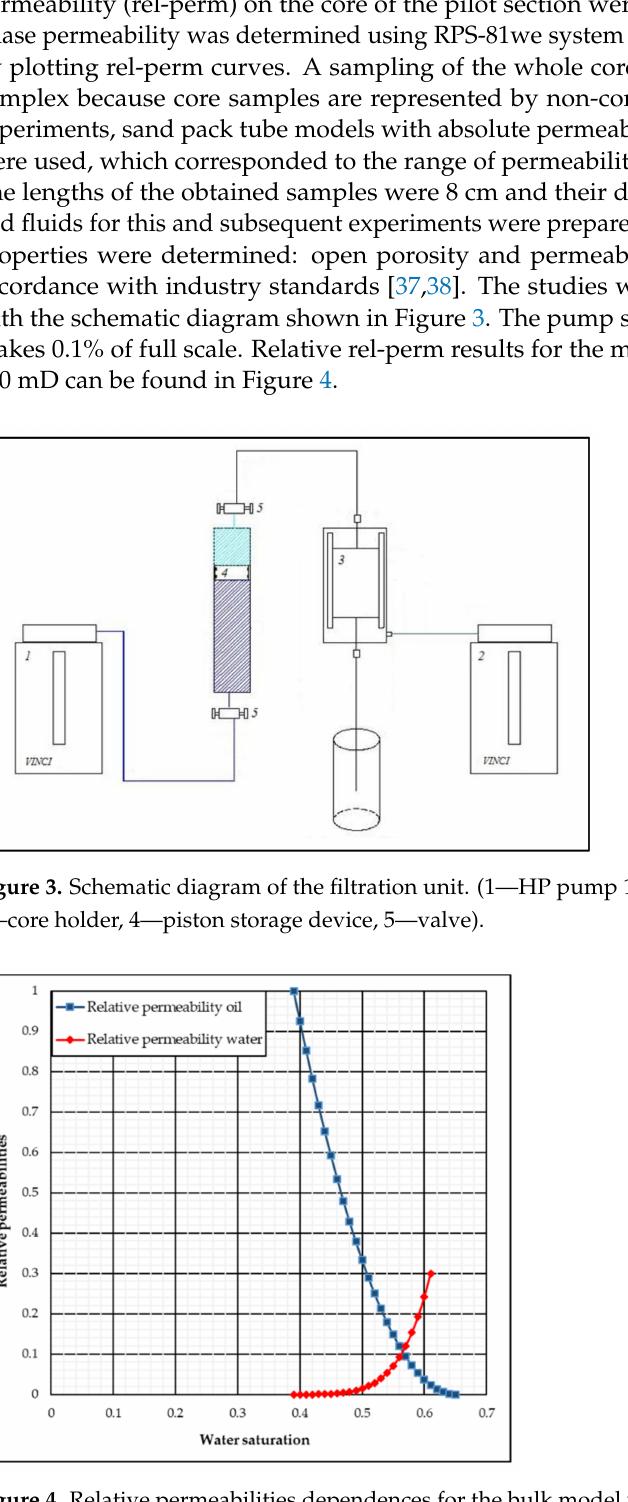
Figure 4. Relative permeabilities dependences for the bulk model with permeability 500